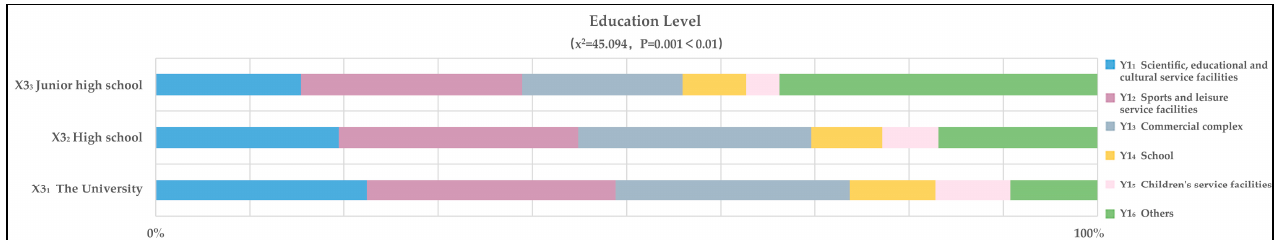
Figure 13. Demand from people with di ff erent educational levels.